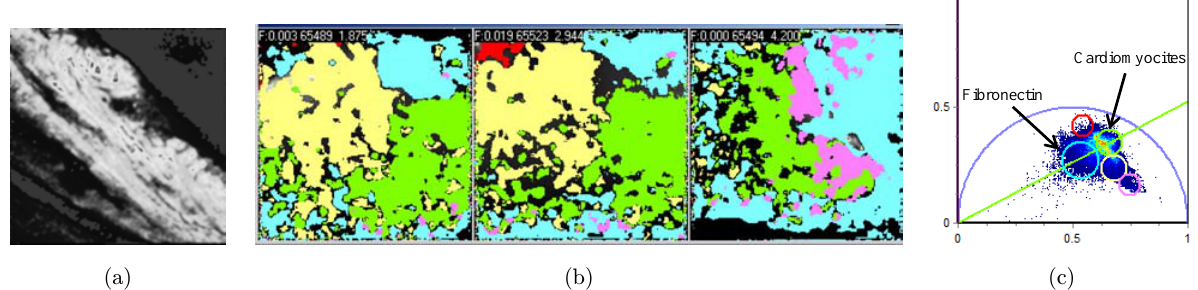
Fig. 11. Intensity image (a), FLIM images (b) and the phasor-plot (c) of the mouse heart. The image was acquired to 700 (cid:1) m